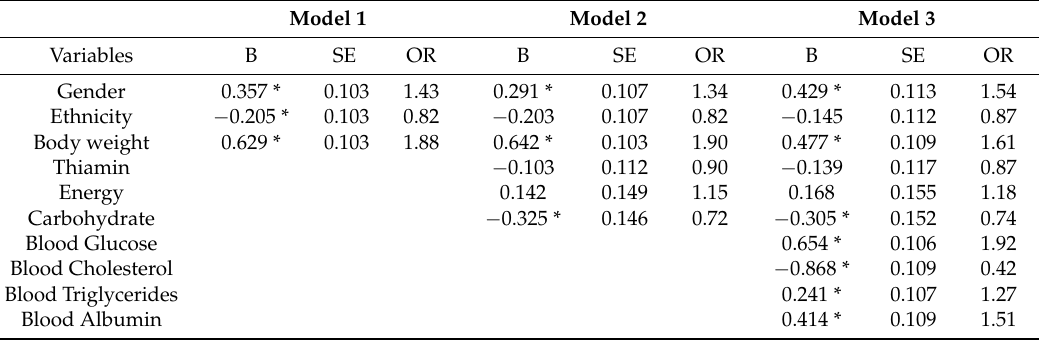
Table 5. Prevalence of hypertension and associations derived by logistic regression